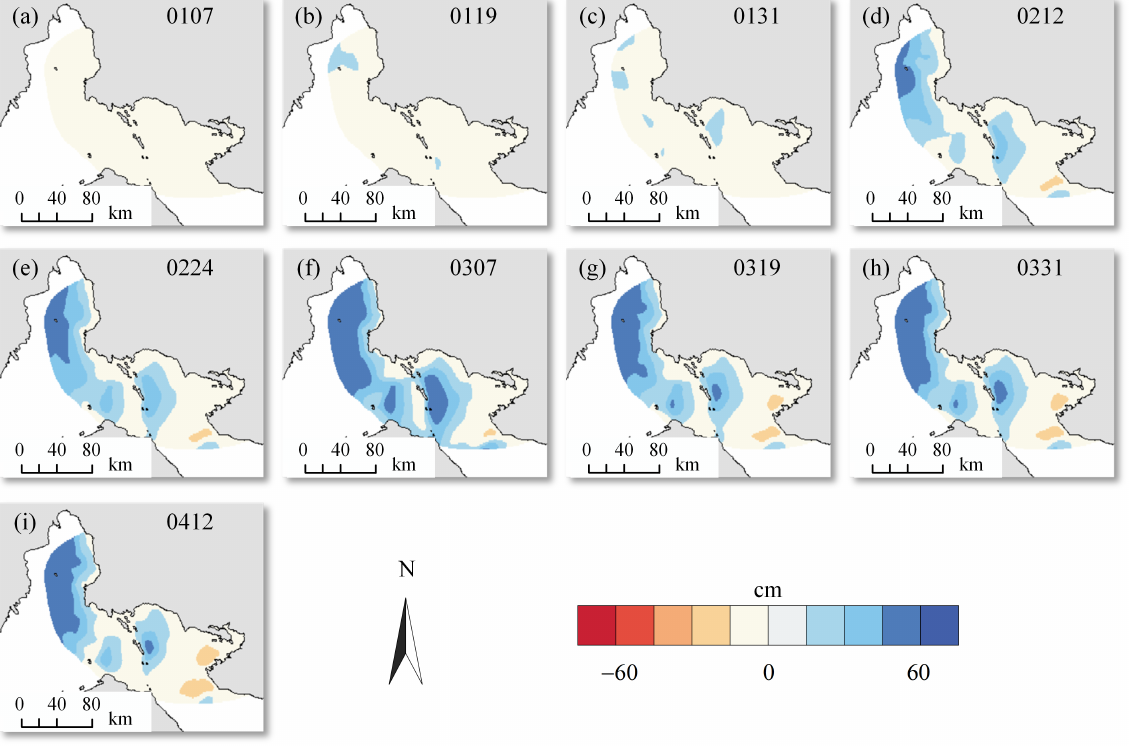
Figure A8. Time-series LOS deformation retrieved from the 2020 descending images: the top-right number of subfigures ( a – i ) represents the corresponding SAR images acquisition